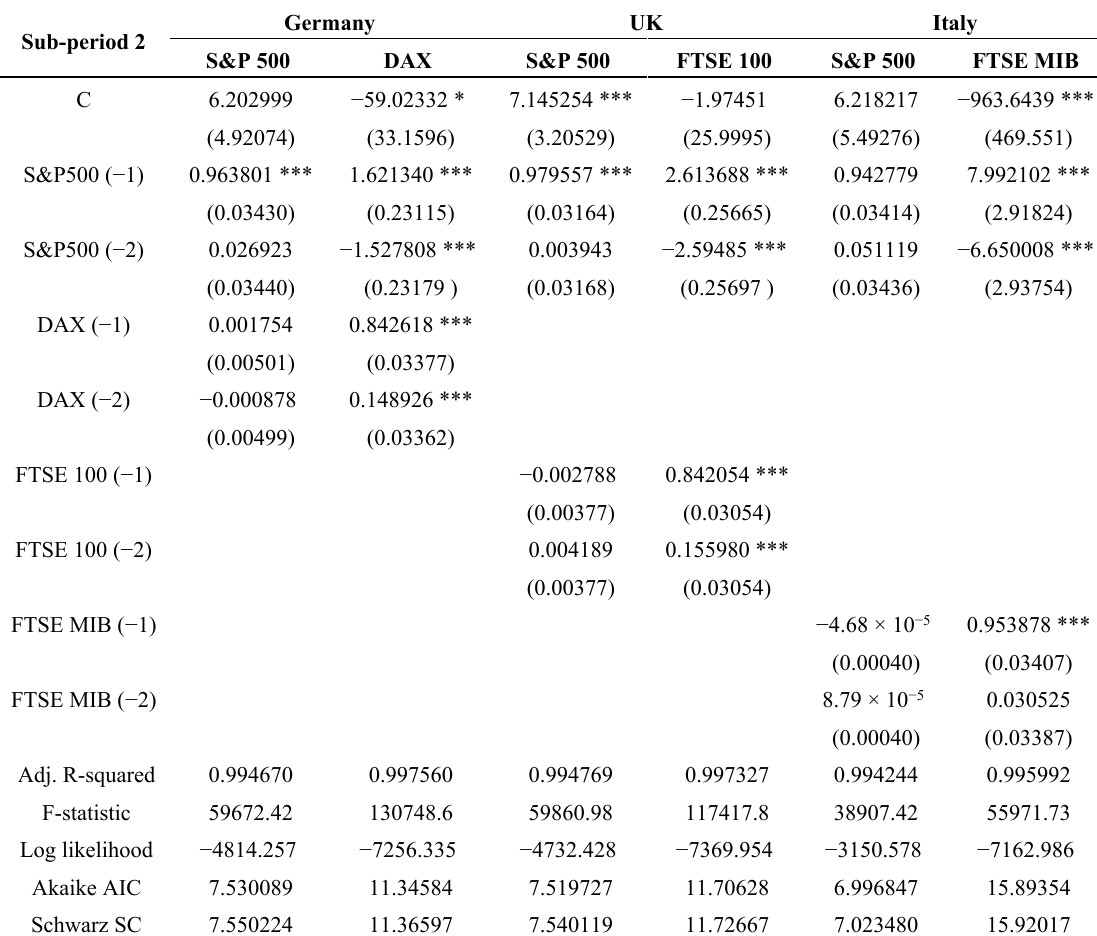
Table A2. Vector Autoregression Estimates for Sub-period 2.